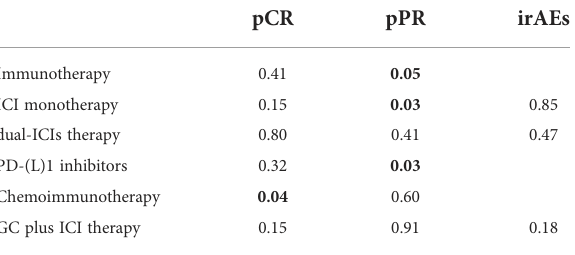
TABLE 5 Publication bias by Egger ’ s regression test (only P value presented). pCR